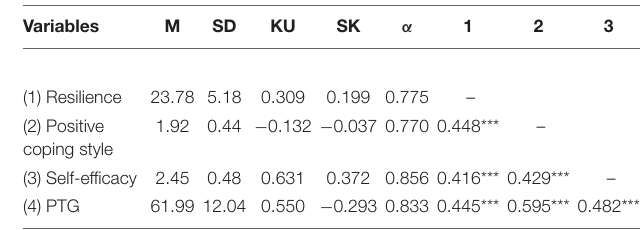
TABLE 1 | Means (M), standard deviations (SD), kurtosis (KU), skewness (SK), correlations, and